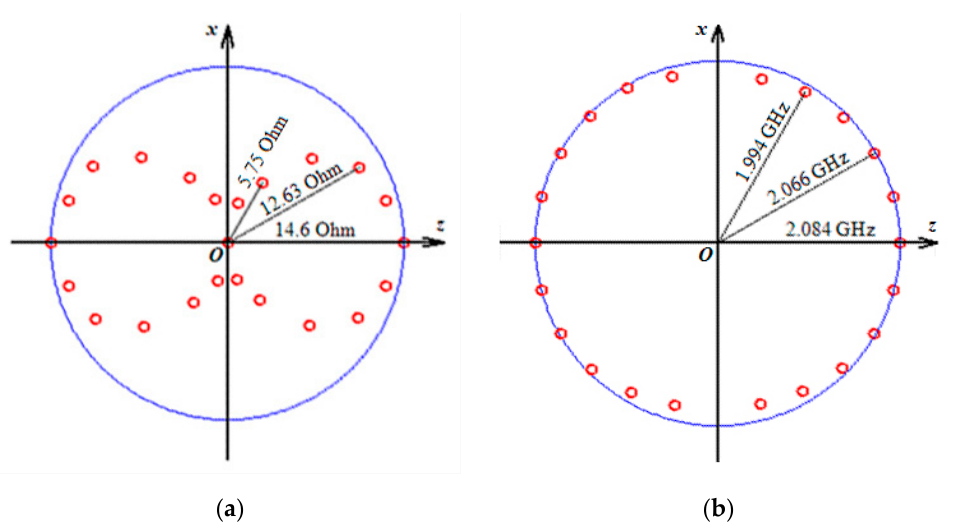
Figure 8. Experimental results of the angular dependence of the maximum impedance variations for the amplitude ( a ) and frequency cases ( b ) for the external field applied in plane of the [Ti(6)/FeNi(50)] 6 /Ti(6)/Cu(500)/Ti(6)/[FeNi(50)/Ti(6)] 6 multilayered GMI element under different angles with respect to the long side of the element.